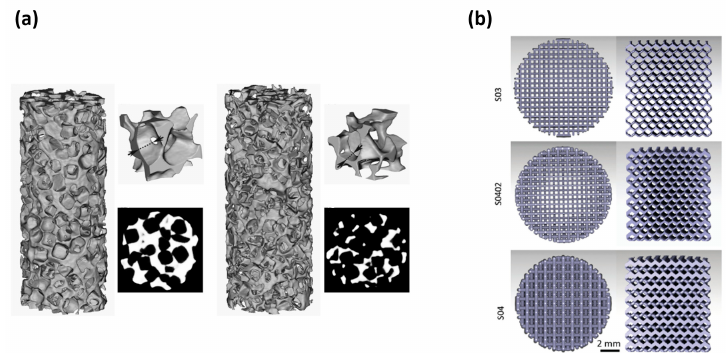
Figure 7. ( a ) The reconstructed 3D models of Zn scaffolds with the two porosities. Reprinted from [56] with permission from Elsevier. ( b ) Topological designs of the AM porous Zn of the three experimental groups [65].